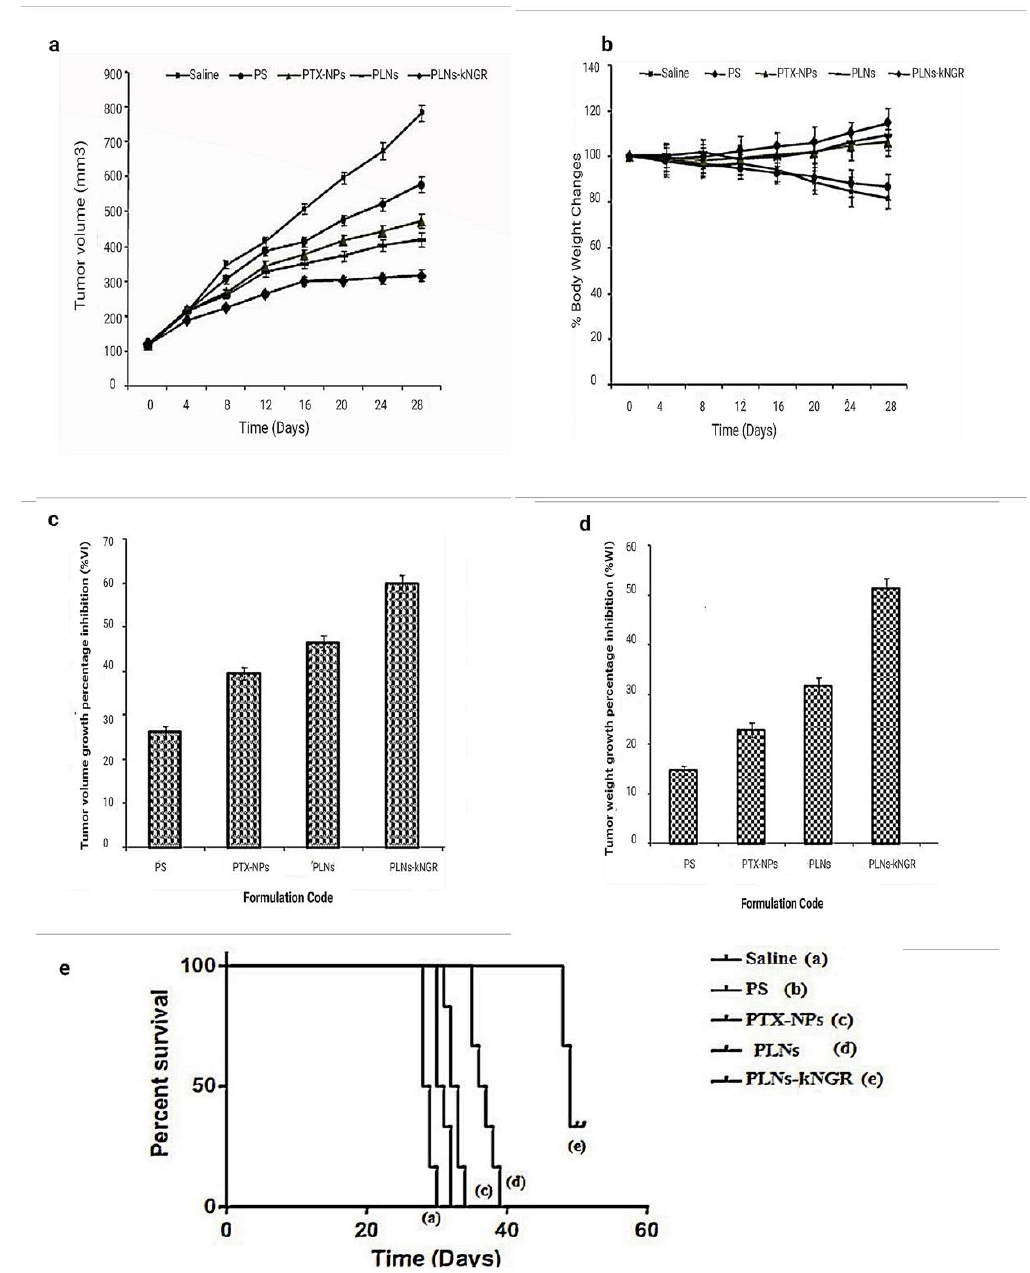
Figure 7. In-Vivo antitumor efficacy of the different PTX formulations in HT-1080 cell-induced tumor in Balb/c mice by changes of ( a ) tumor volumes ( b ) % body weight changes of Balb/c mice by bearing HT-1080 tumor cells ( c ) the effect of free PTX and PTX-loaded formulations on volume growth percentage inhibition (% VI) of different treatments ( d ) The effect of various formulations on tumor weight growth percentage inhibition (%WI) of different treatments on growth of established HT-1080 tumor-induced Balb c/mice at the end of therapy ( e ) Kaplan–Meier survival curves of HT-1080 cell-bearing mice treated with different PTX formulations.